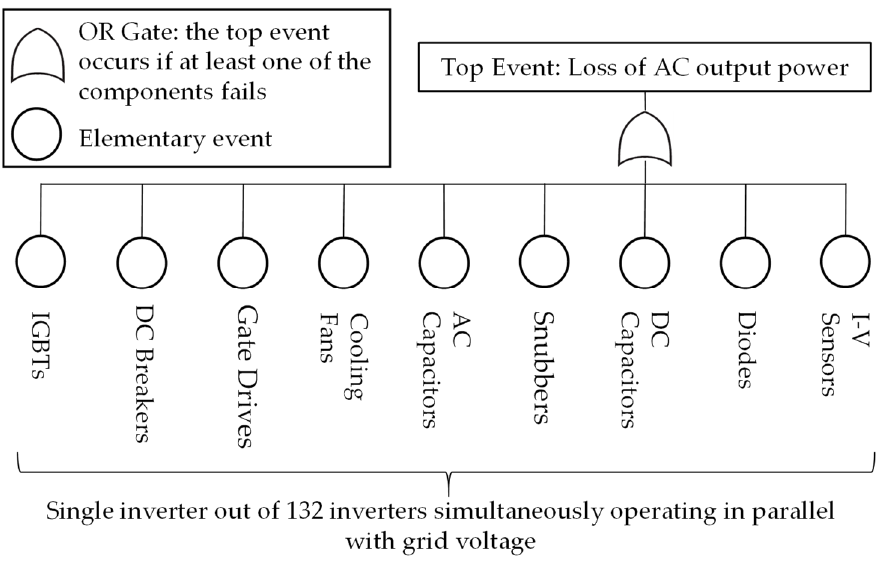
Figure 4. Fault tree for the components of the DC/AC converters under analysis.